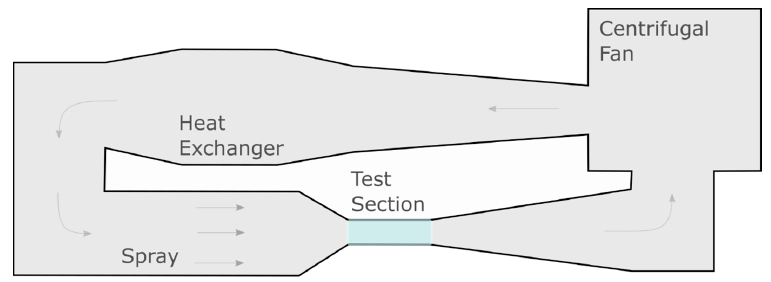
Figure 2. Icing wind tunnel.